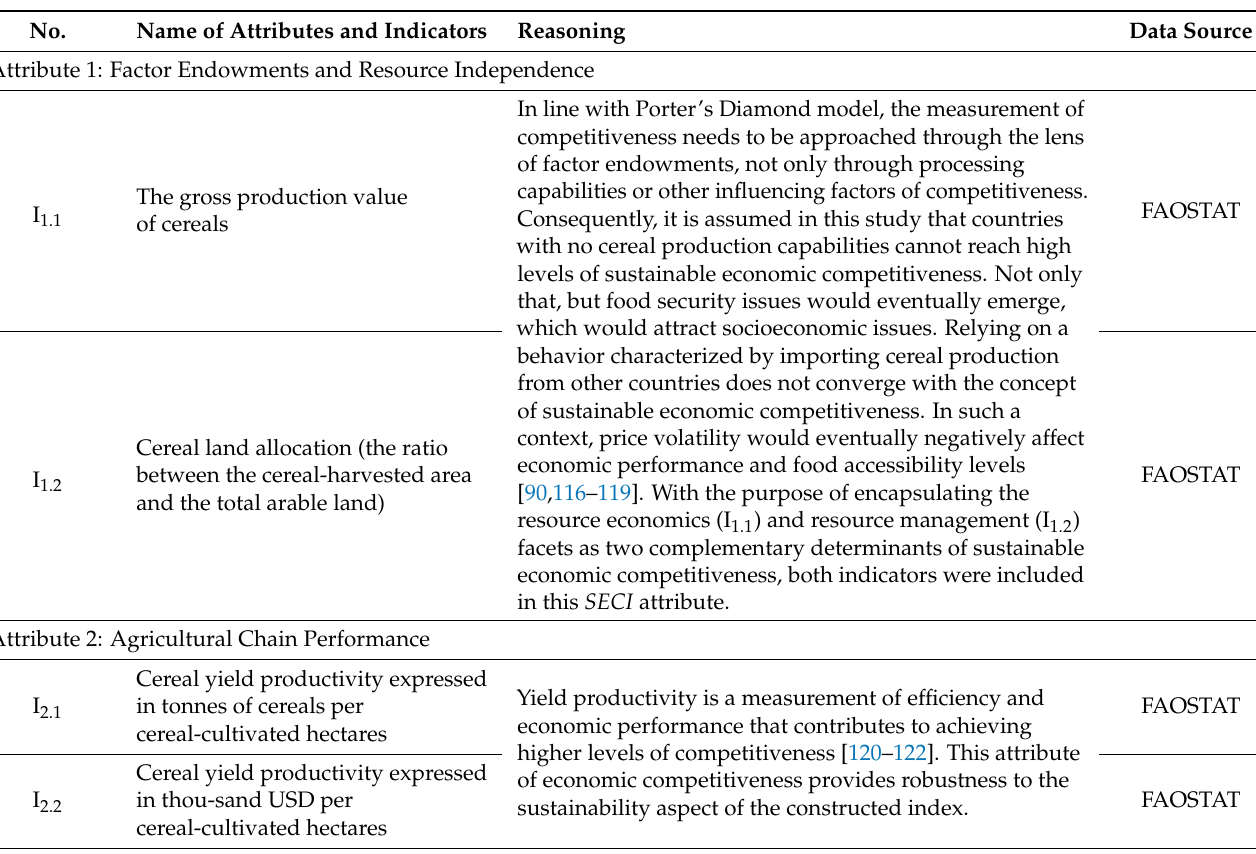
Table 1. Description of the attributes and indicators included in the construction of the sustainable economic competitiveness